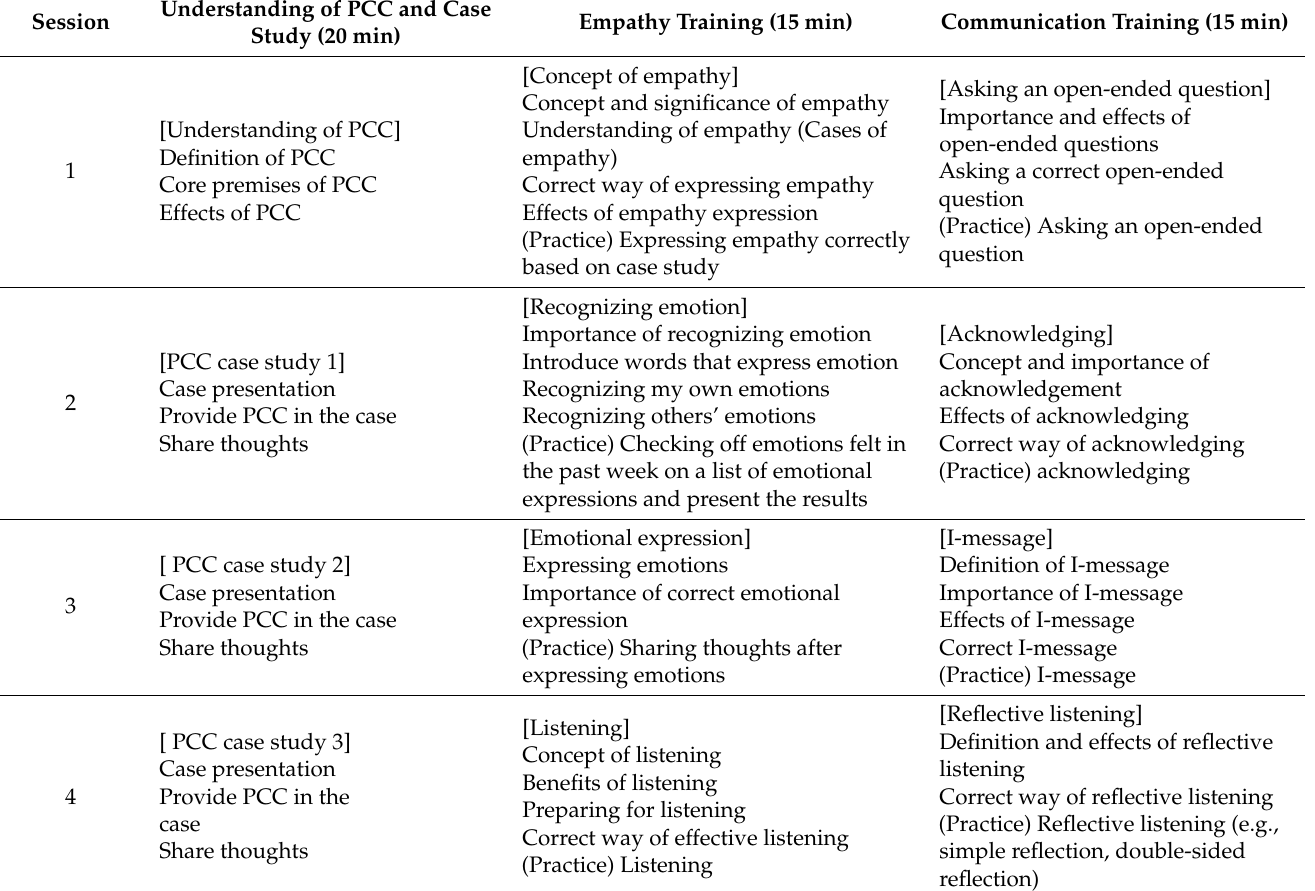
Table 1. Educational contents of comprehensive person-centered care (PCC) education